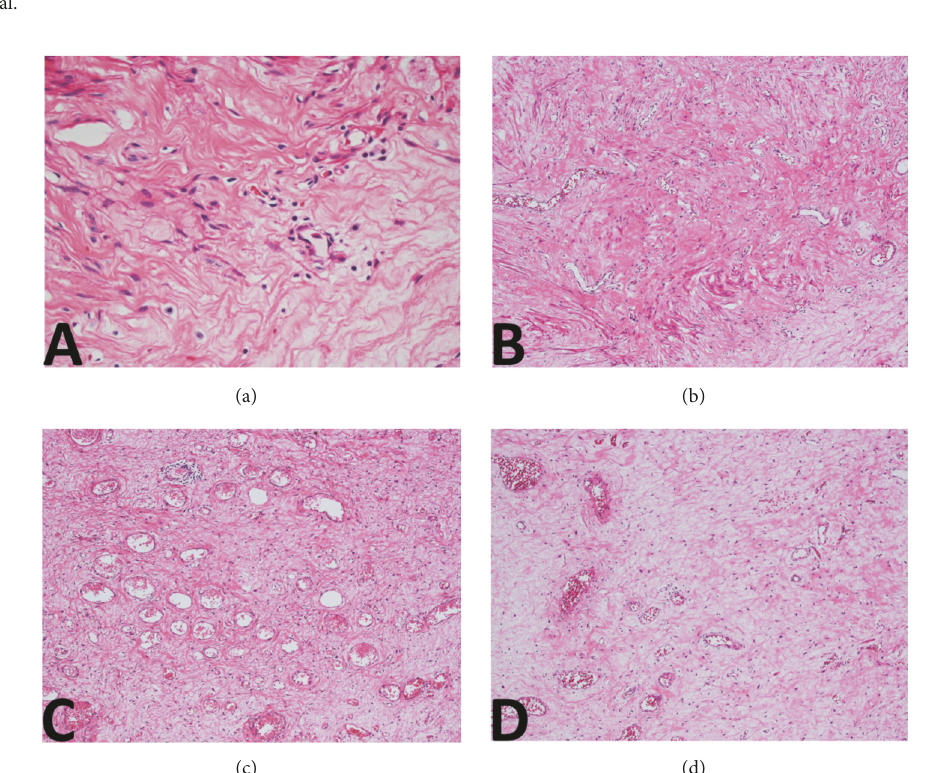
Figure 3: Tumor cells were short and spindle-shaped, arranged in no overt architecture. The nuclei were oval, without prominent atypia. The intervening matrix was edematous and myxoid ((a); × 400;HE). In some regions, fine collagen as well as dense collagen was detected ((b); × 100;HE). The vast majority of blood vessels were small and thin-walled ((c); × 100;HE). Some medium-sized blood vessels were also identified within the lesion ((d); × 100;HE). There was no specific distribution pattern of the